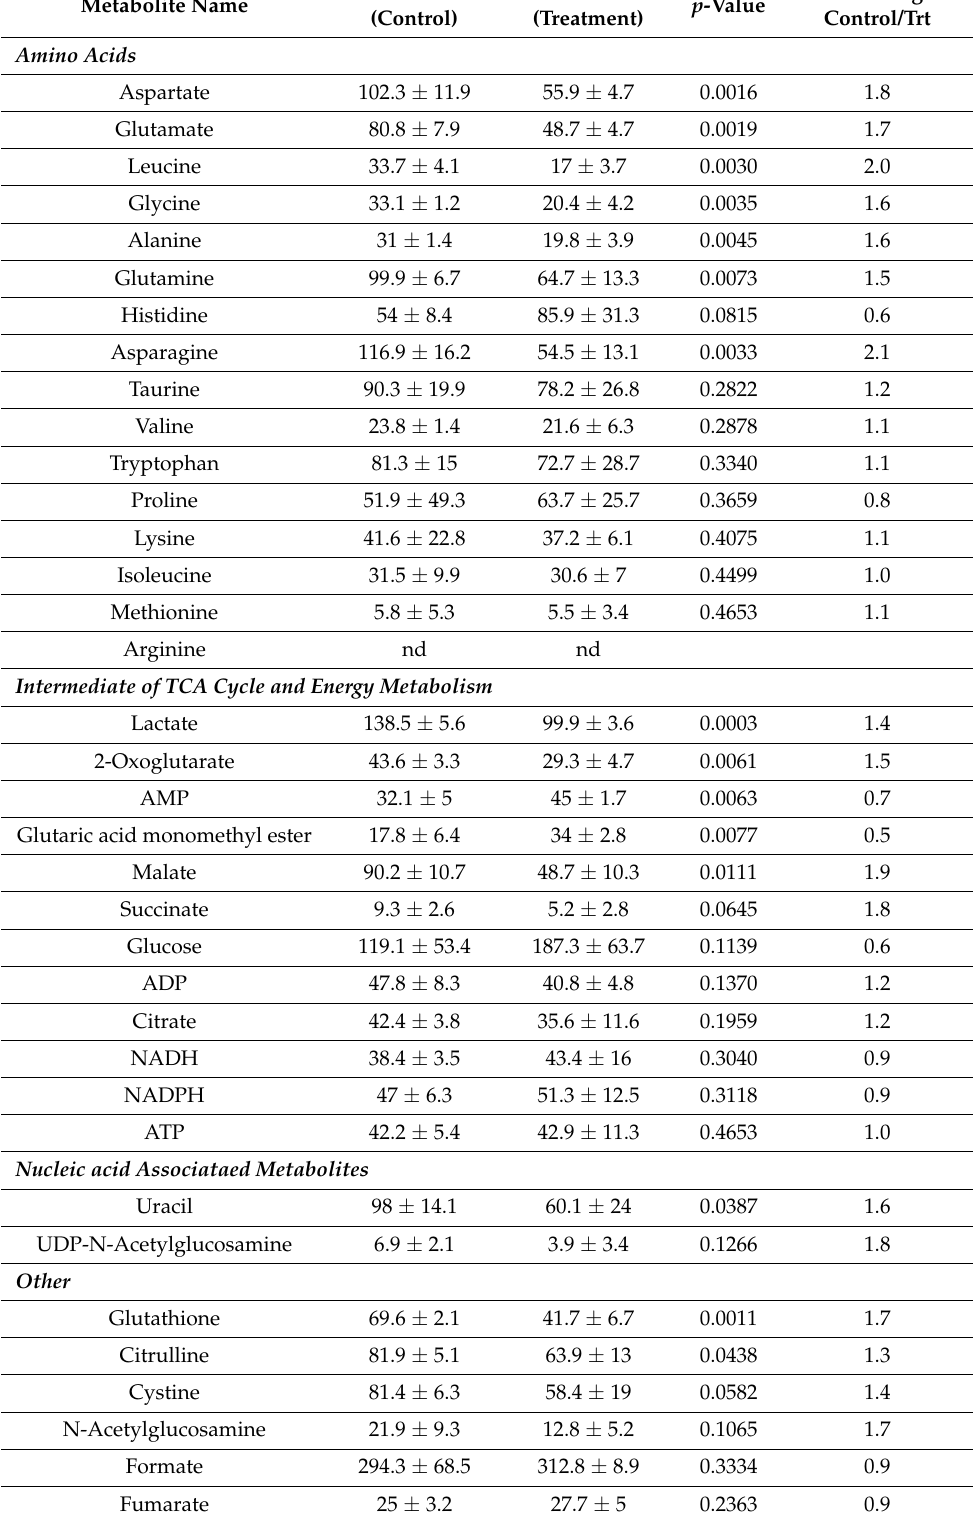
Table 1. List of metabolite concentrations determined using NMR in A549 (A) H1299 (B) cells. p -values less than 0.05 were considered statistically significant for univariate analysis. Treatment column indicates the samples with the 30 µ M treatment of δ T. All the concentrations are reported in µ